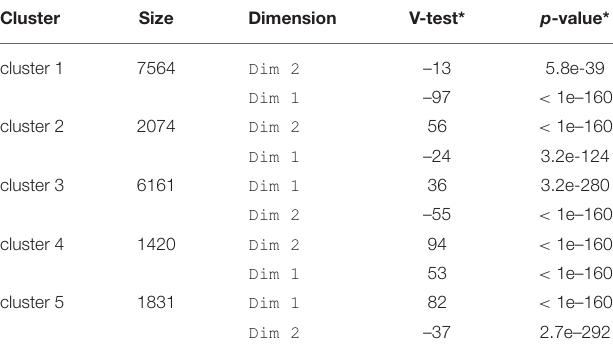
TABLE 4 | Results of the hierarchical clustering on principal dimensions.